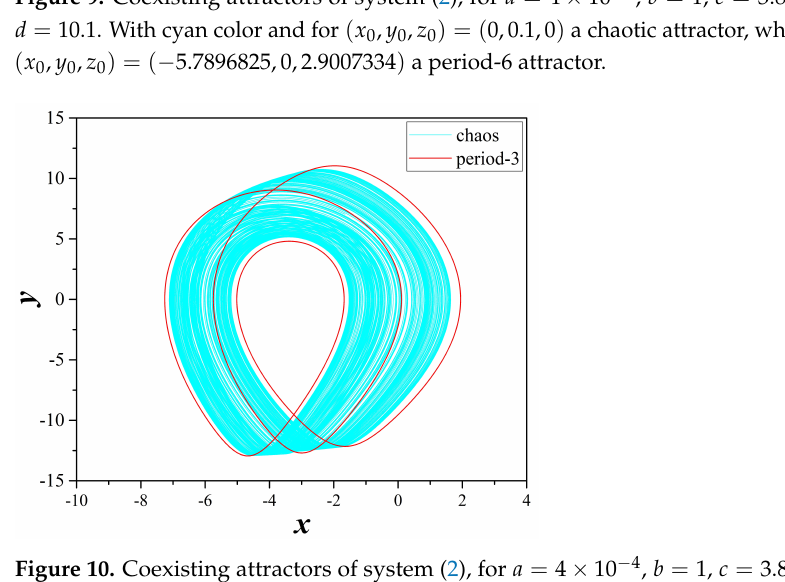
Figure 10. Coexisting attractors of system (2), for a = 4 × 10 − 4 , b = 1, c = 3.846 × 10 − 4 , e = 1 and d = 10.5. With cyan color and for ( x 0 , y 0 , z 0 ) = ( 0,0.1,0 ) a chaotic attractor, while with red color and ( x ) = ( − 5.7439696,0,2.8417025 ) a period-6 0 , y 0 , z 0